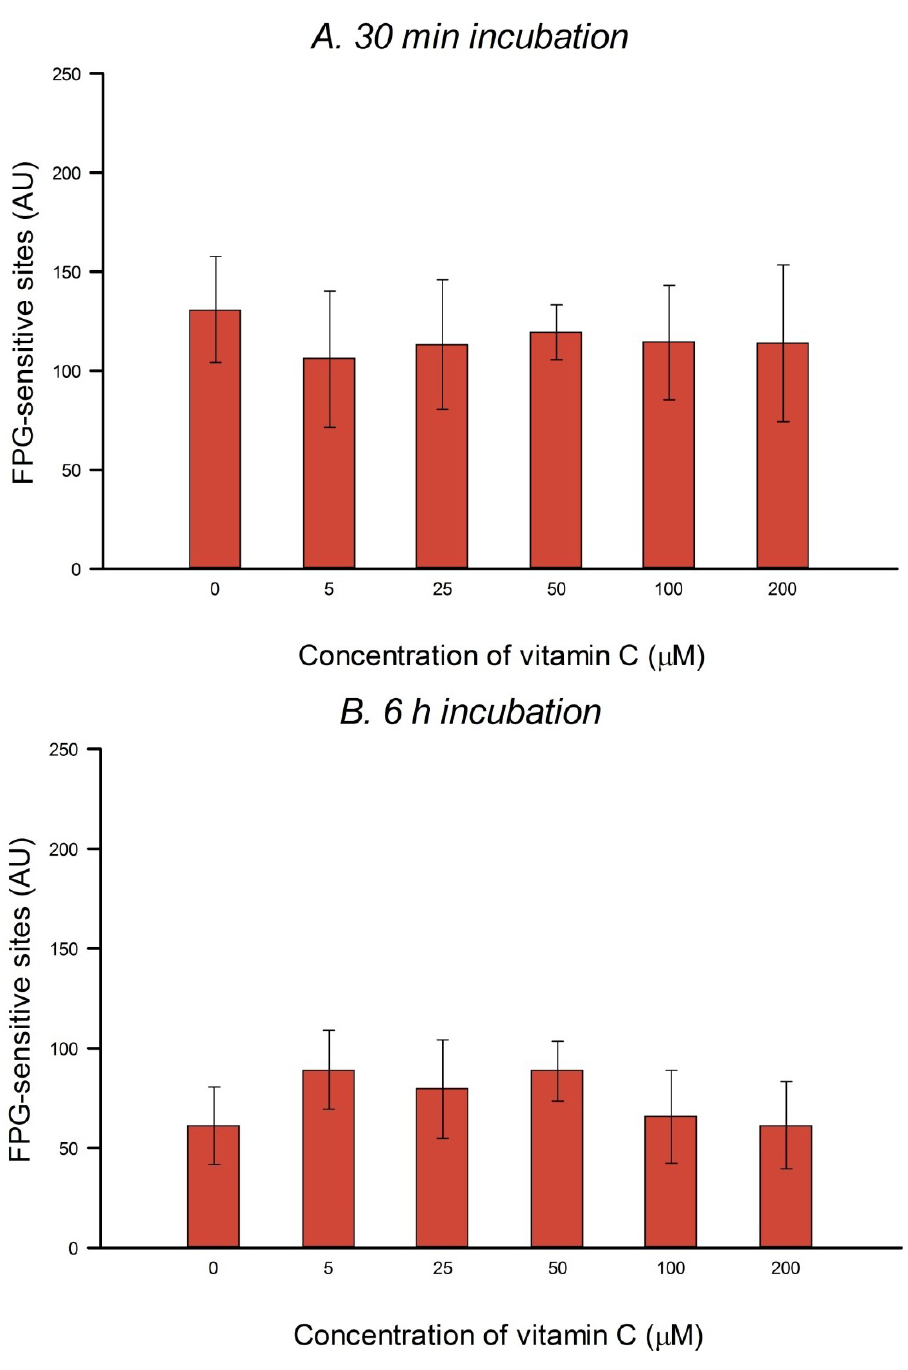
Figure 3. Effect of pre-incubation of HeLa cells with different concentrations of vitamin C for 30 min ( A ) or 6 h ( B ) on FPG-sensitive sites induced by Ro plus light. Net Ro-induced damage was calculated by subtracting the FPG-sensitive sites without Ro plus light (as in Figure 1) from the FPG-sensitive sites with Ro plus light. Bars: SD calculated from the results of 3 independent experiments. No significant effects were